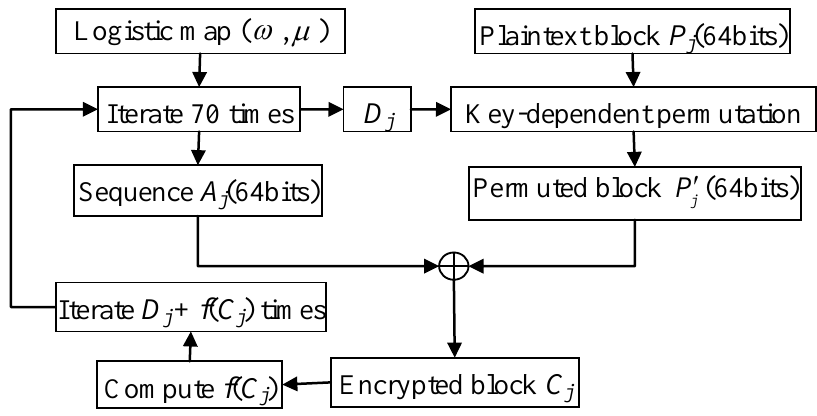
Figure 1. Block diagram of Wang et al.